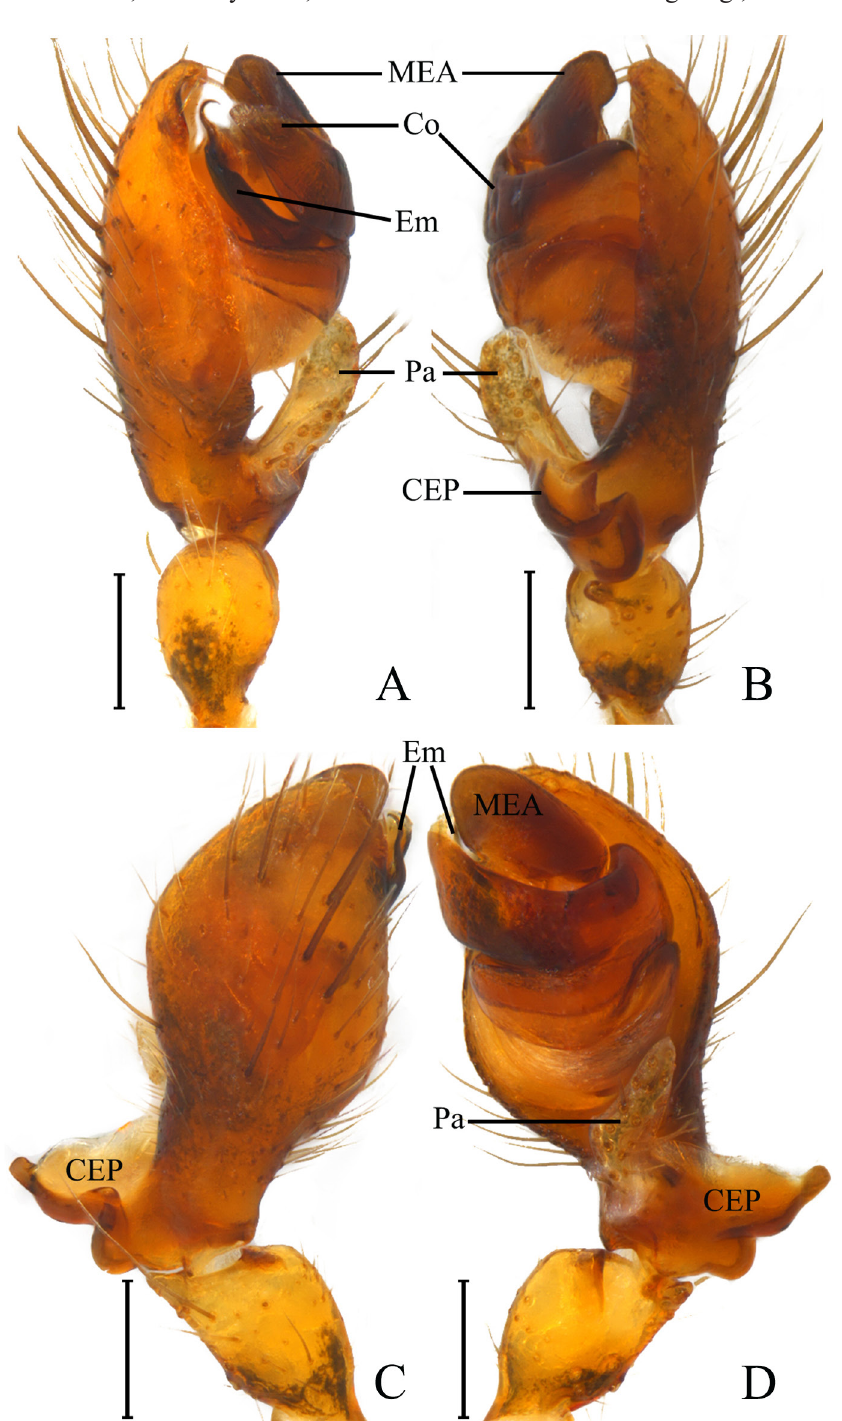
Fig. 2. Meta hamata sp. nov. Left palp, ♂, holotype (HNU-CGY25): A . Prolateral view. B . Retrolateral view. C . Dorsal view. D . Ventral view. Scale bars: A–D = 0.2